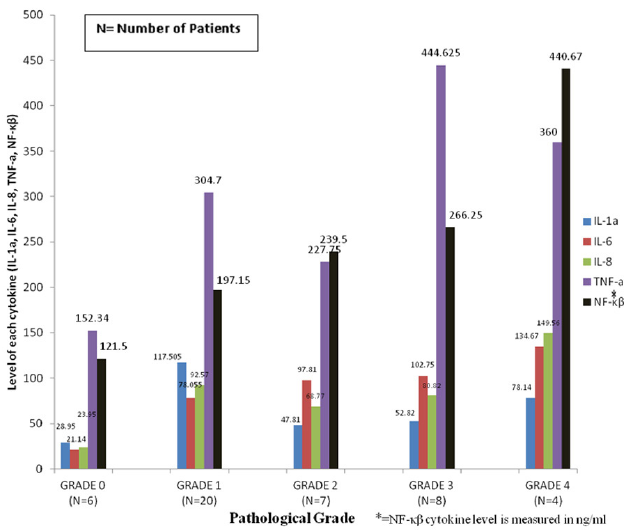
Fig. 3 - Comparison of expression of different cytokines-NF- κ β, IL-1α, IL-6, IL-8 and TNF-α in different grades of